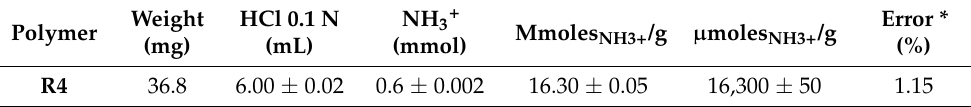
Table 4. Content of NH 3+ of R4 by potentiometric titration of an exactly weighed amount of resins. Weight Polymer (mg)